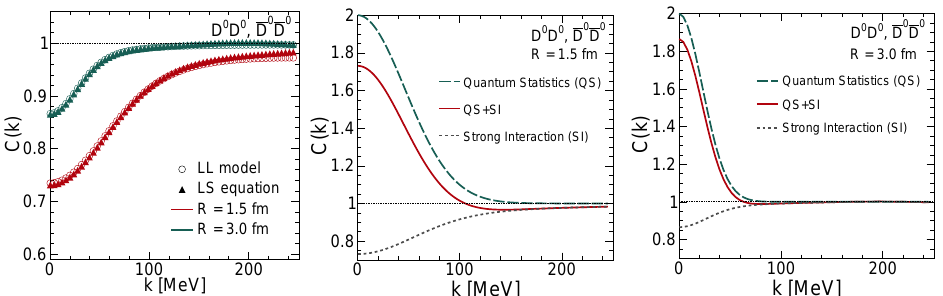
Figure 1: Left : LL model (empty circles) and CF obtained from LS equation code (filled triangles) for two values of R : 1.5 fm (red) and 3.0 fm (green). Center, Right : Two-particle CF contributions: SI (grey, short dashed line), total (QS + SI; red, full line) and QS (green, long dashed line) as a function of momentum k , using the source width as R = 1.5 fm (left) and R = 3.0 fm